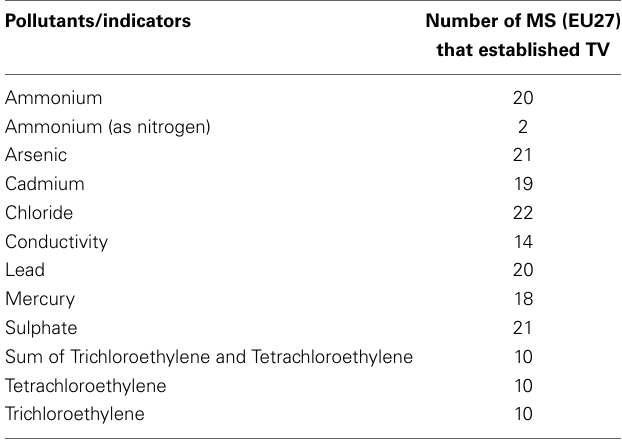
Table 1 | Number of member states (MS) that have established threshold values (TV) for the substances included in annex II of the GWD (European Commission,